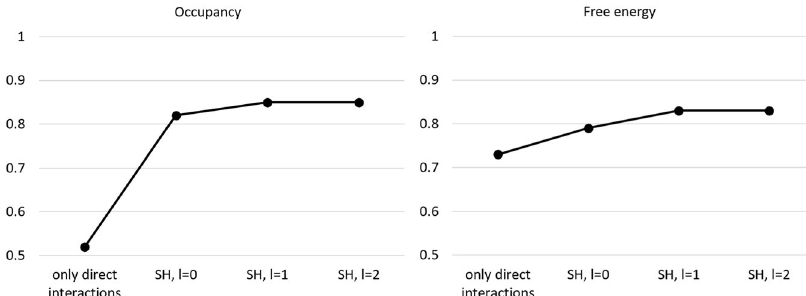
Fig. 7 Accuracy of regression model. Regression coef fi cient r for correlating occupancy and free energy values of neural-network predictions with original WATsite